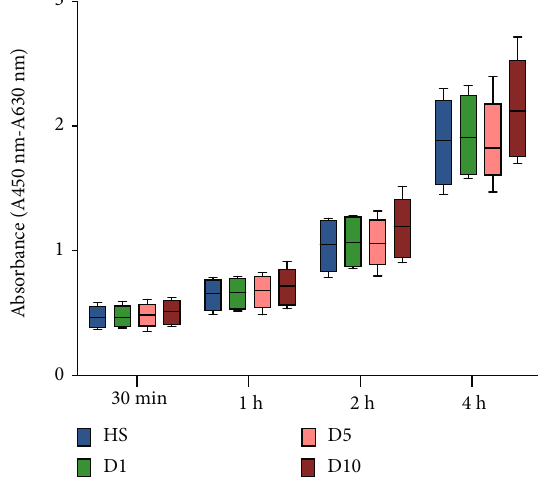
Figure 4: WST assay. Results were observed after cultivation of cells for 24 hours in medium containing di ff erent sera (HS, D1, D5, or D10 serum). No signi fi cant di ff erences were observed between any of the groups at any of the time points analyzed (30 minutes, 1 hour, 2 hours, and 4 hours) ( n = 4 ; N = 3